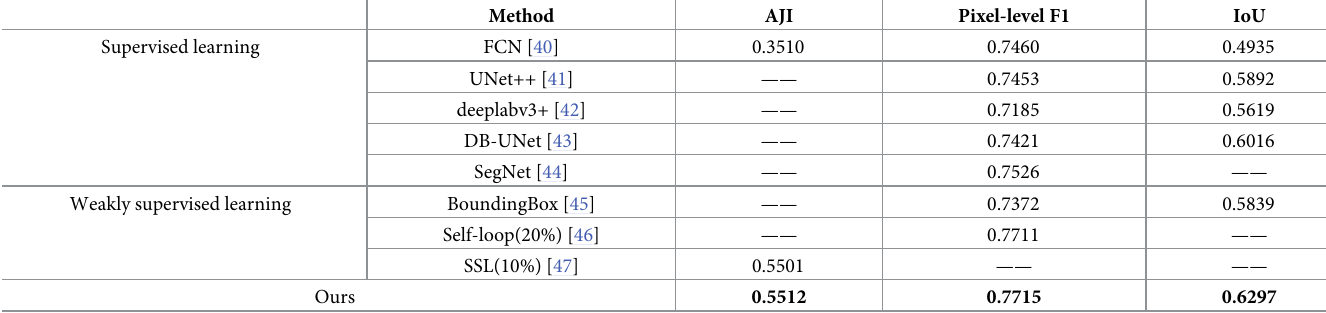
Table 7. Comparison experimental results on MoNuSeg